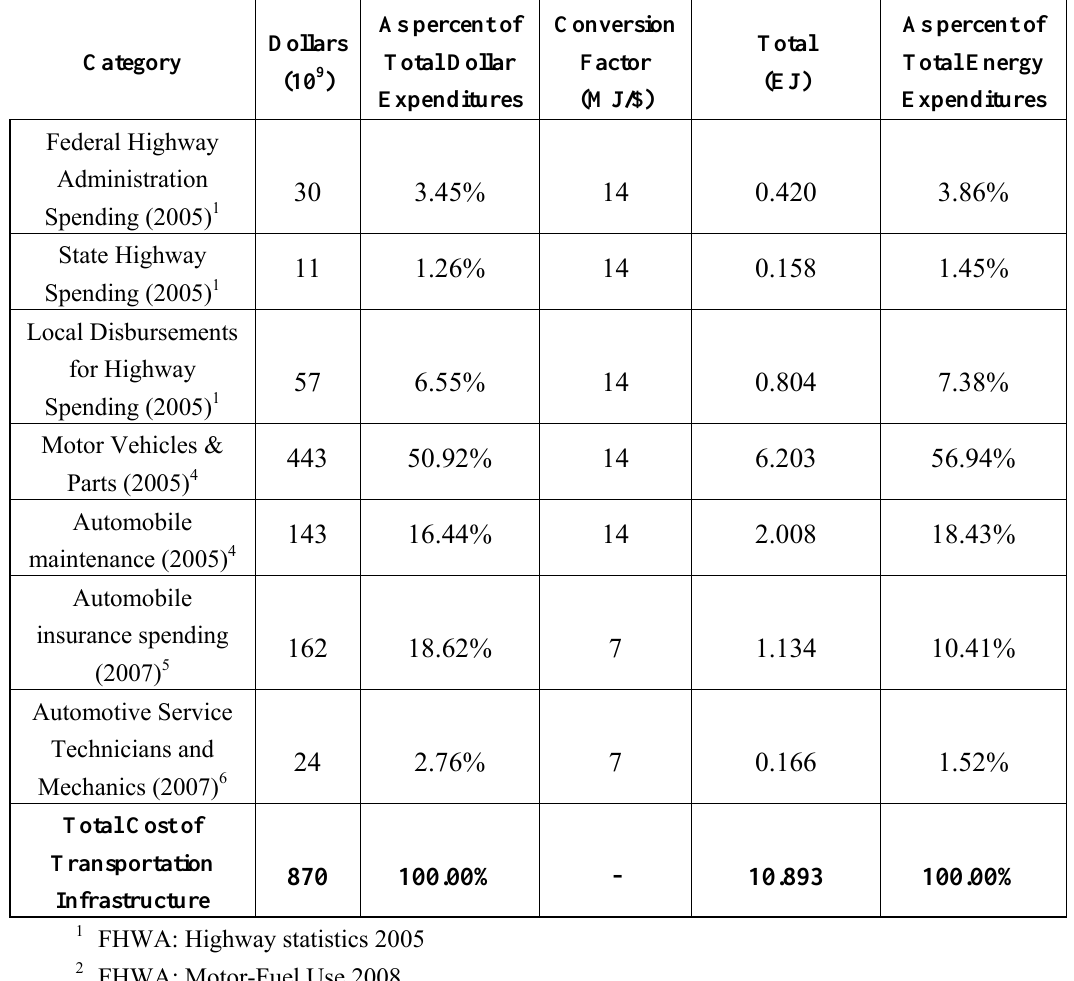
Table 2. Estimates of energy and dollar expenditures within the total U.S. transportation